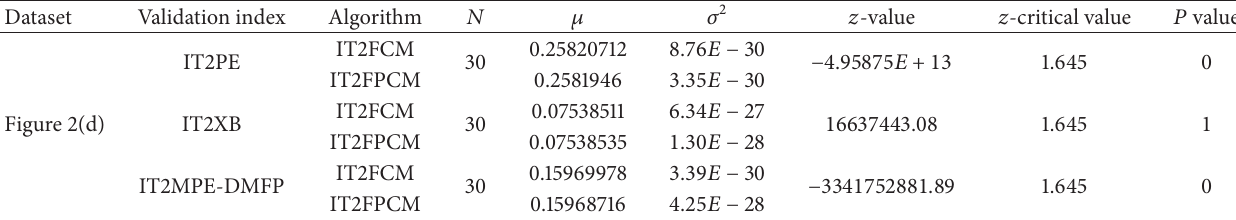
Table 40: Statistical test for the IT2PE, IT2XB, and IT2MPE-DMFP indices of validation for Figure 2(d) clustering.